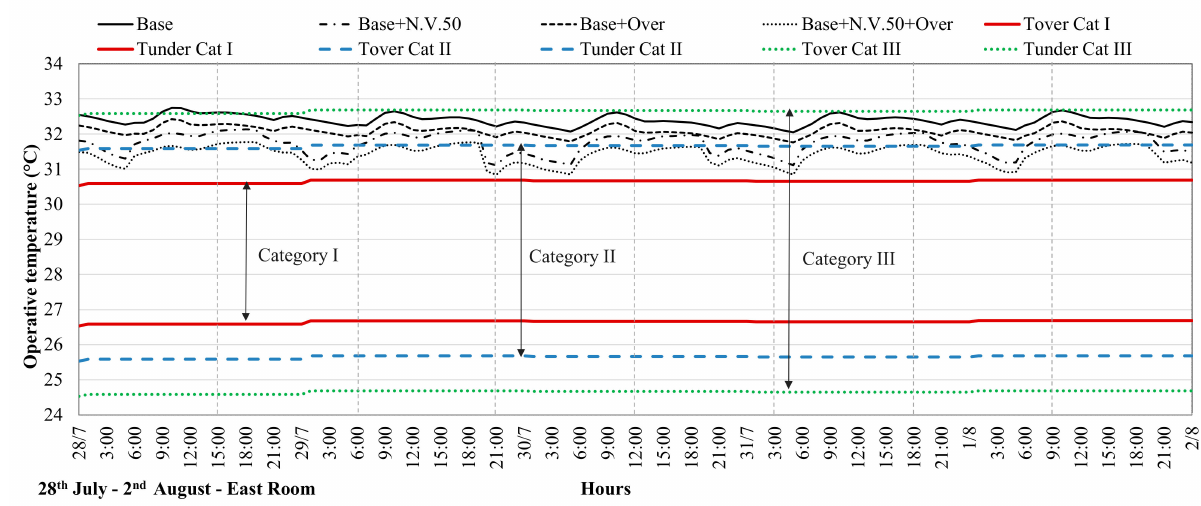
Figure 5. Hourly profile of operative temperature under all investigated cases and threshold values (T under, T over) for category I, II, and